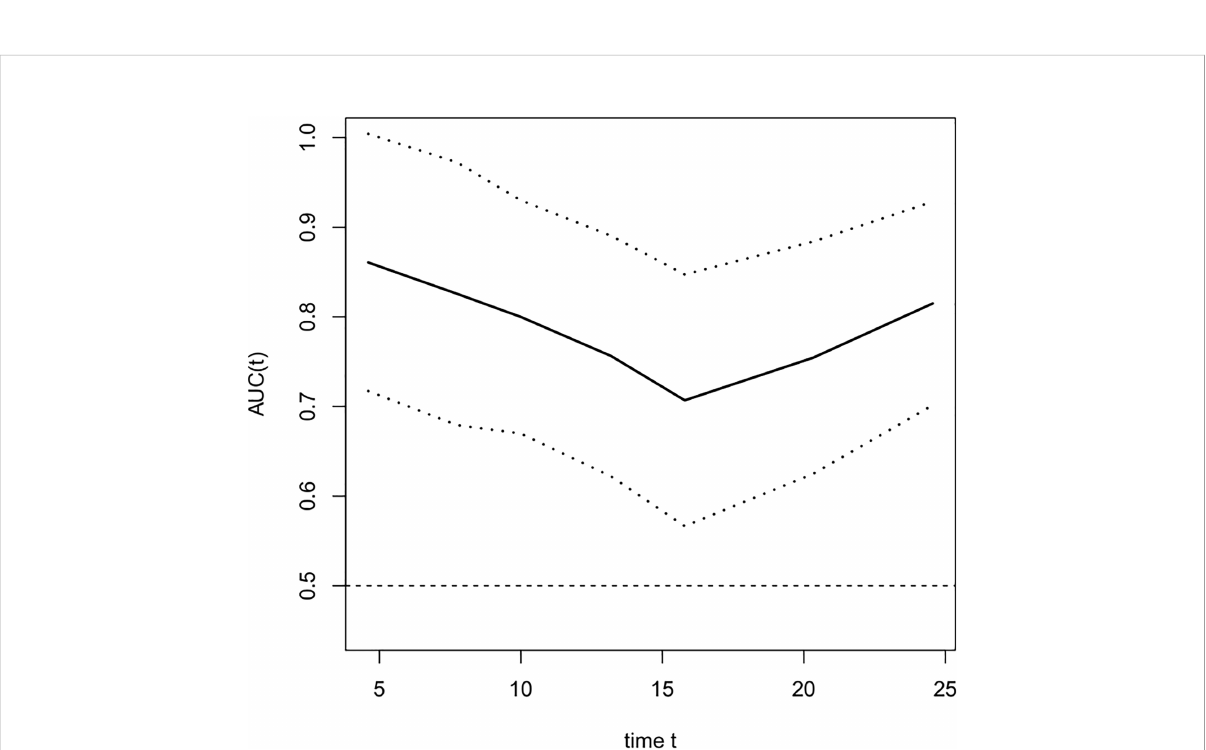
FIGURE 8 The fi tting curve of follow-up time dependent AUC for predicting progression-free survival. The solid line is the fi tted line, and the dashed lines on both sides are 95% CI. With the extension of follow-up time, AUC was mostly stable,